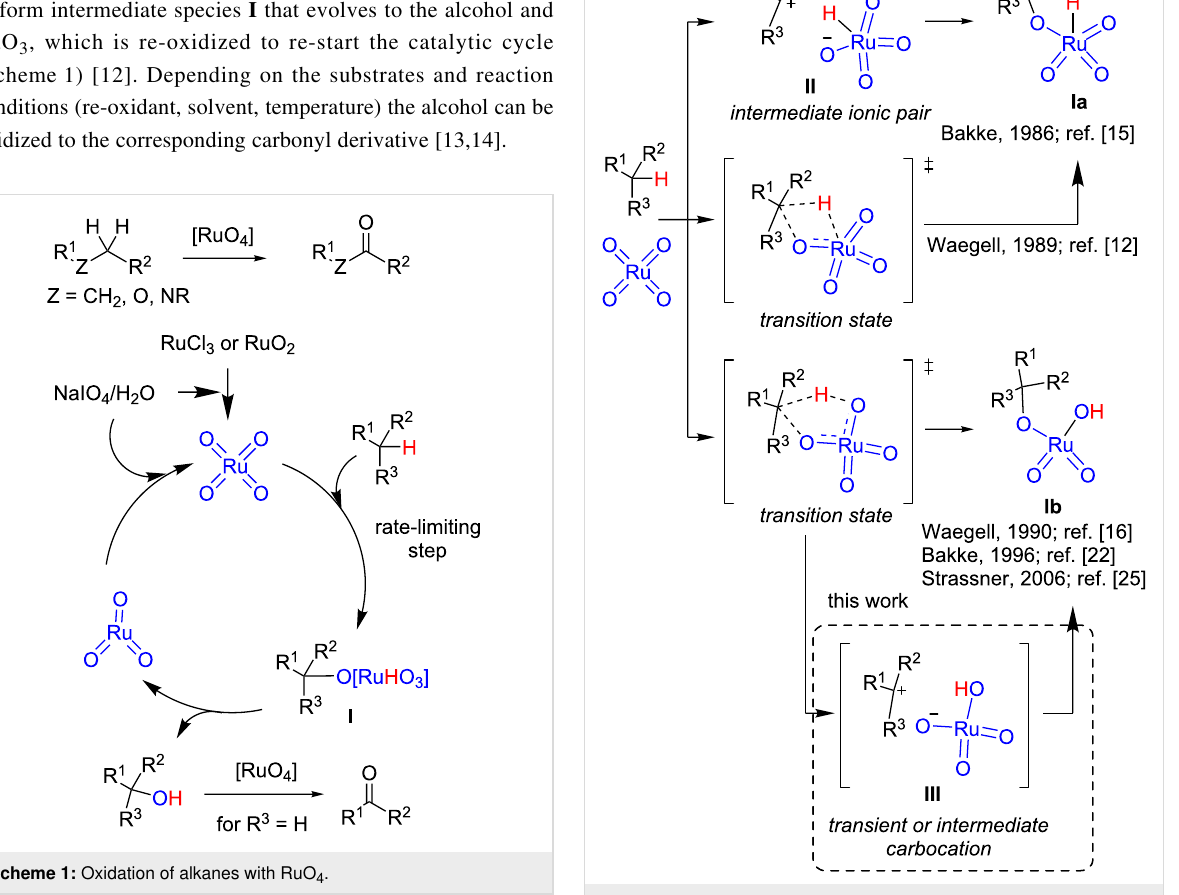
Scheme 2: Mechanisms for RuO 4 oxidation of